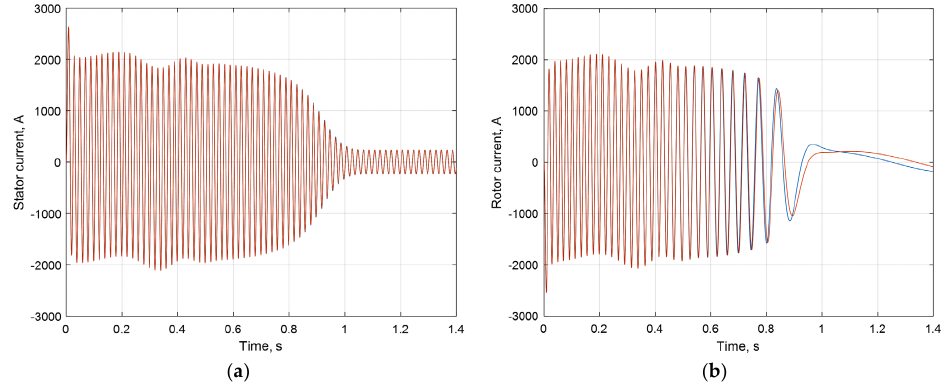
Figure 9. Simulation results of the IM’s starting mode: stator current ( a ), rotor current ( b )—etalon results (red), AVIS method of the 1st and 2nd order (blue).